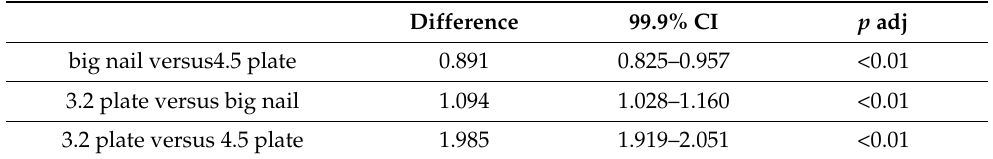
Table 3. Differences between constructs in torsion. The big nail stands for the exchange medullary nail, the 3.2 plate stands for the small additional plate, and the 4.5 plate stands for the large additional plate. Difference 99.9% CI p adj big nail versus4.5 plate